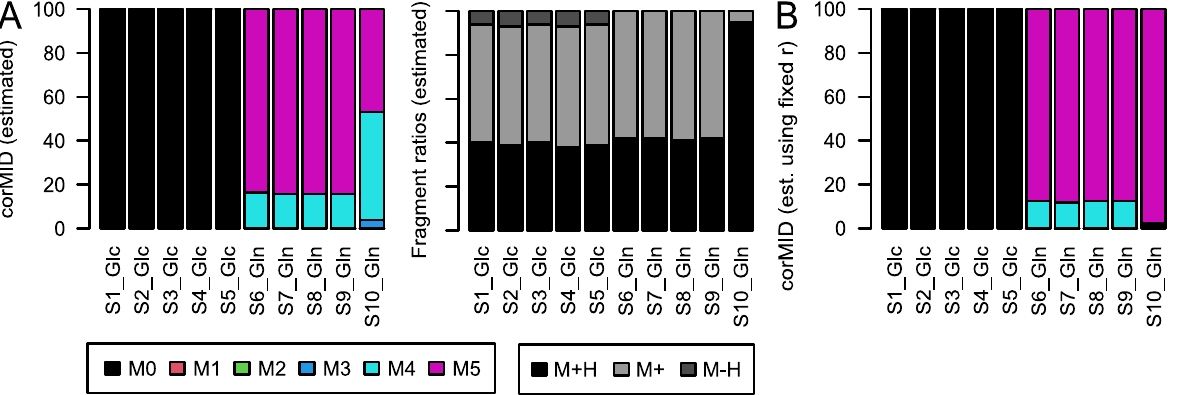
Figure 5. corMID and fragment distribution r for Gln after Glc labeling (S1 – 5) and after Gln labeling (S6 – 10). ( A ) corMID and r estimated from the measured intensities. ( B ) corMID estimated using the median values from ( A ) as a fixed r . The according rawMIDs for all files can be found in Figure S4.